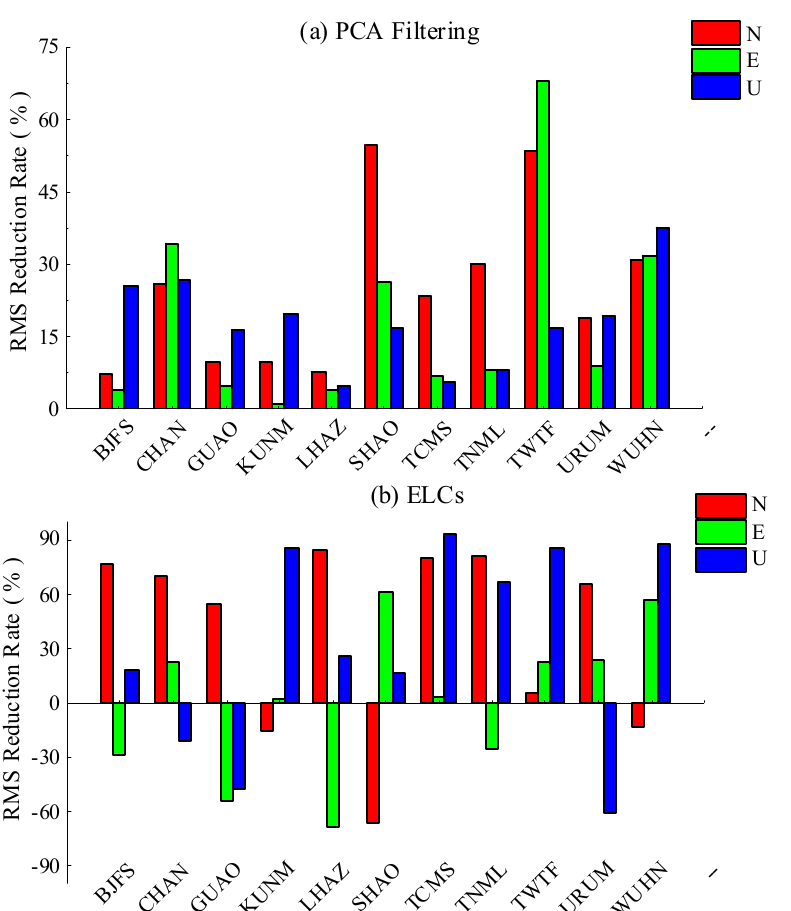
Figure 10. RMS reduction rate before and after PCA filtering ( a ) and environmental loading corrections ( b ) in the residual time series of IGS stations in China area.